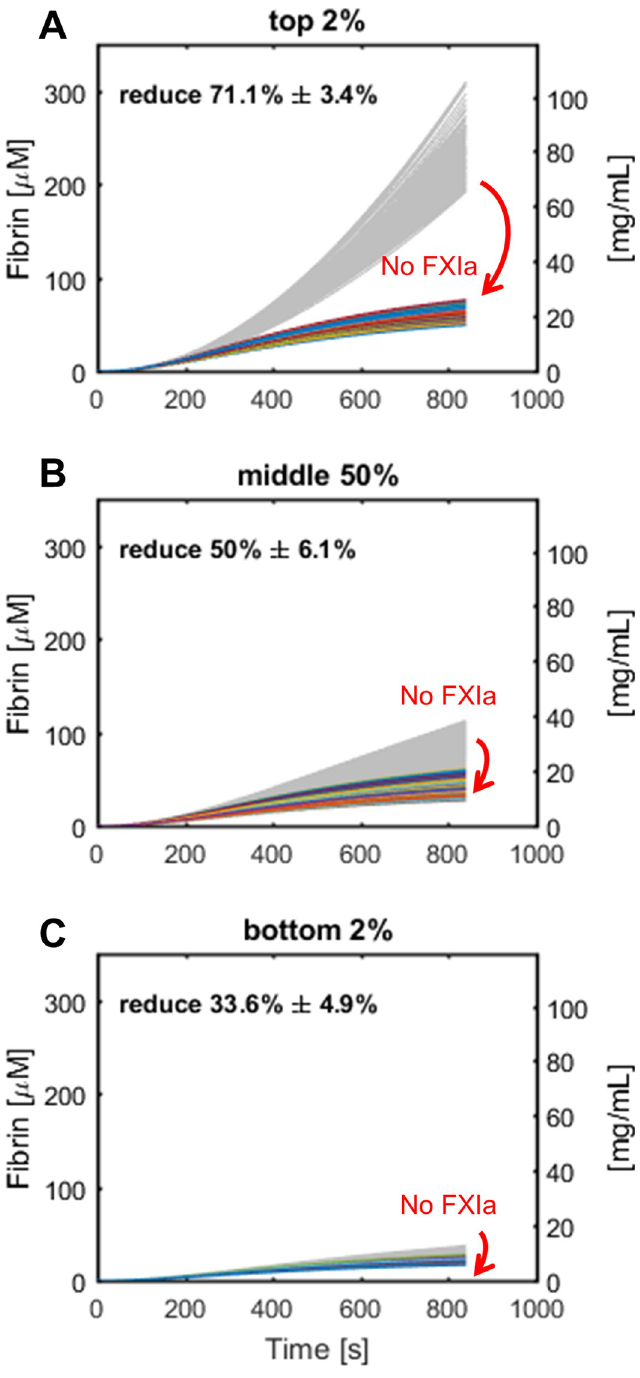
Fig 8. The potency of the blockage of FXIa varies over the subsets of fibrin concentration. The effect of inhibition of FXIa on fibrin concentration of top 2% (A), middle 50% (B), and bottom 2% (C) of 10,000 simulations.